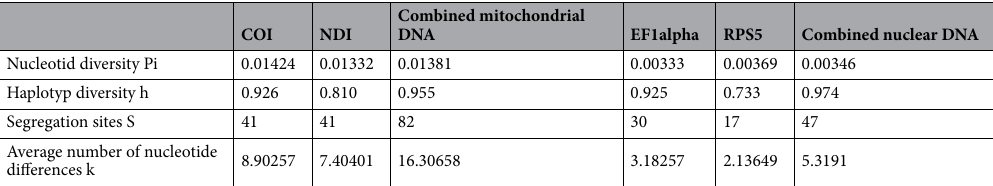
Table 1. Genetic diversity parameters of the mitochondrial and nuclear DNA markers of the separated and combined sequences of Erebia pronoe